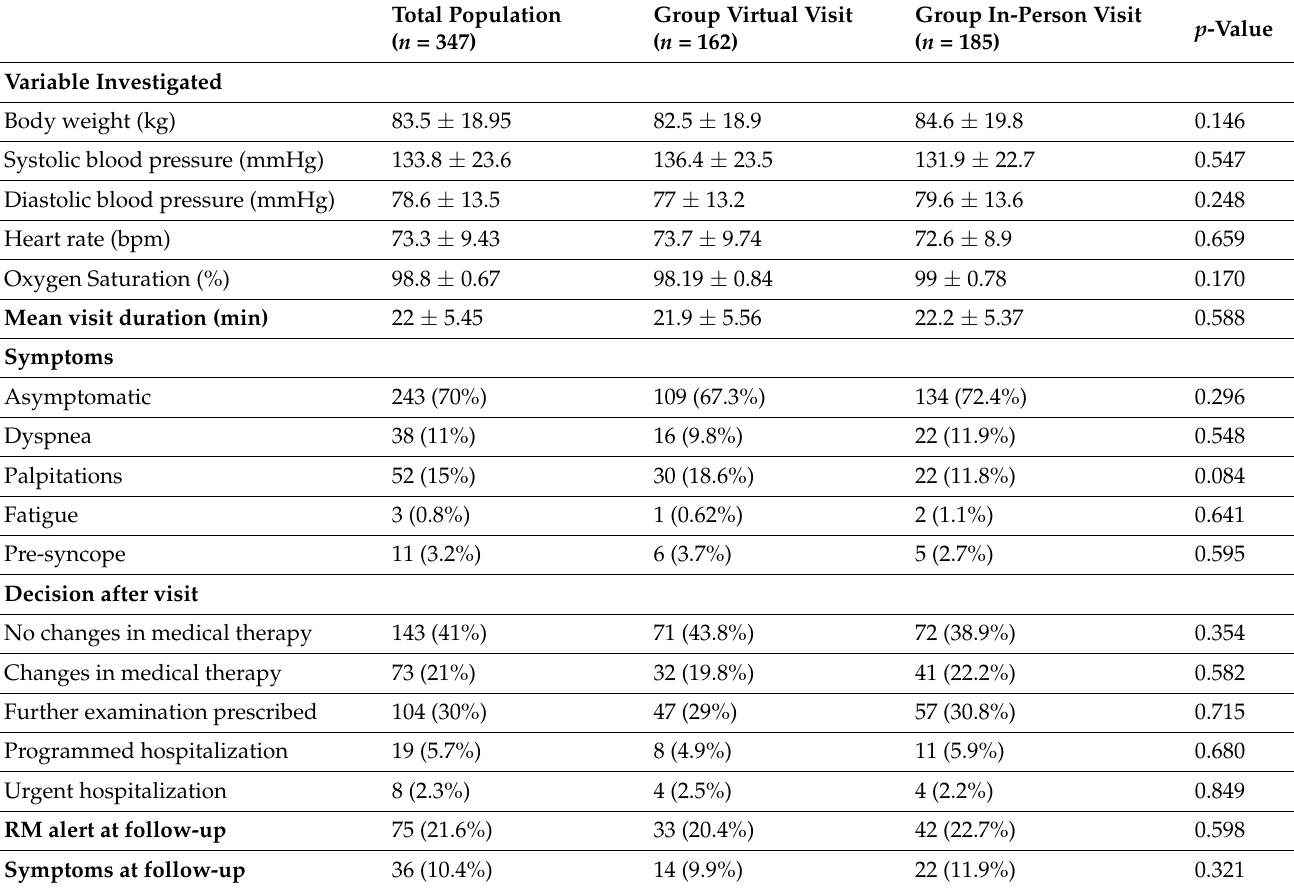
Table 2. Vital parameters, visit duration, presenting symptoms, RM alerts and decision after visit and RM and symptoms at follow-up. RM: remote